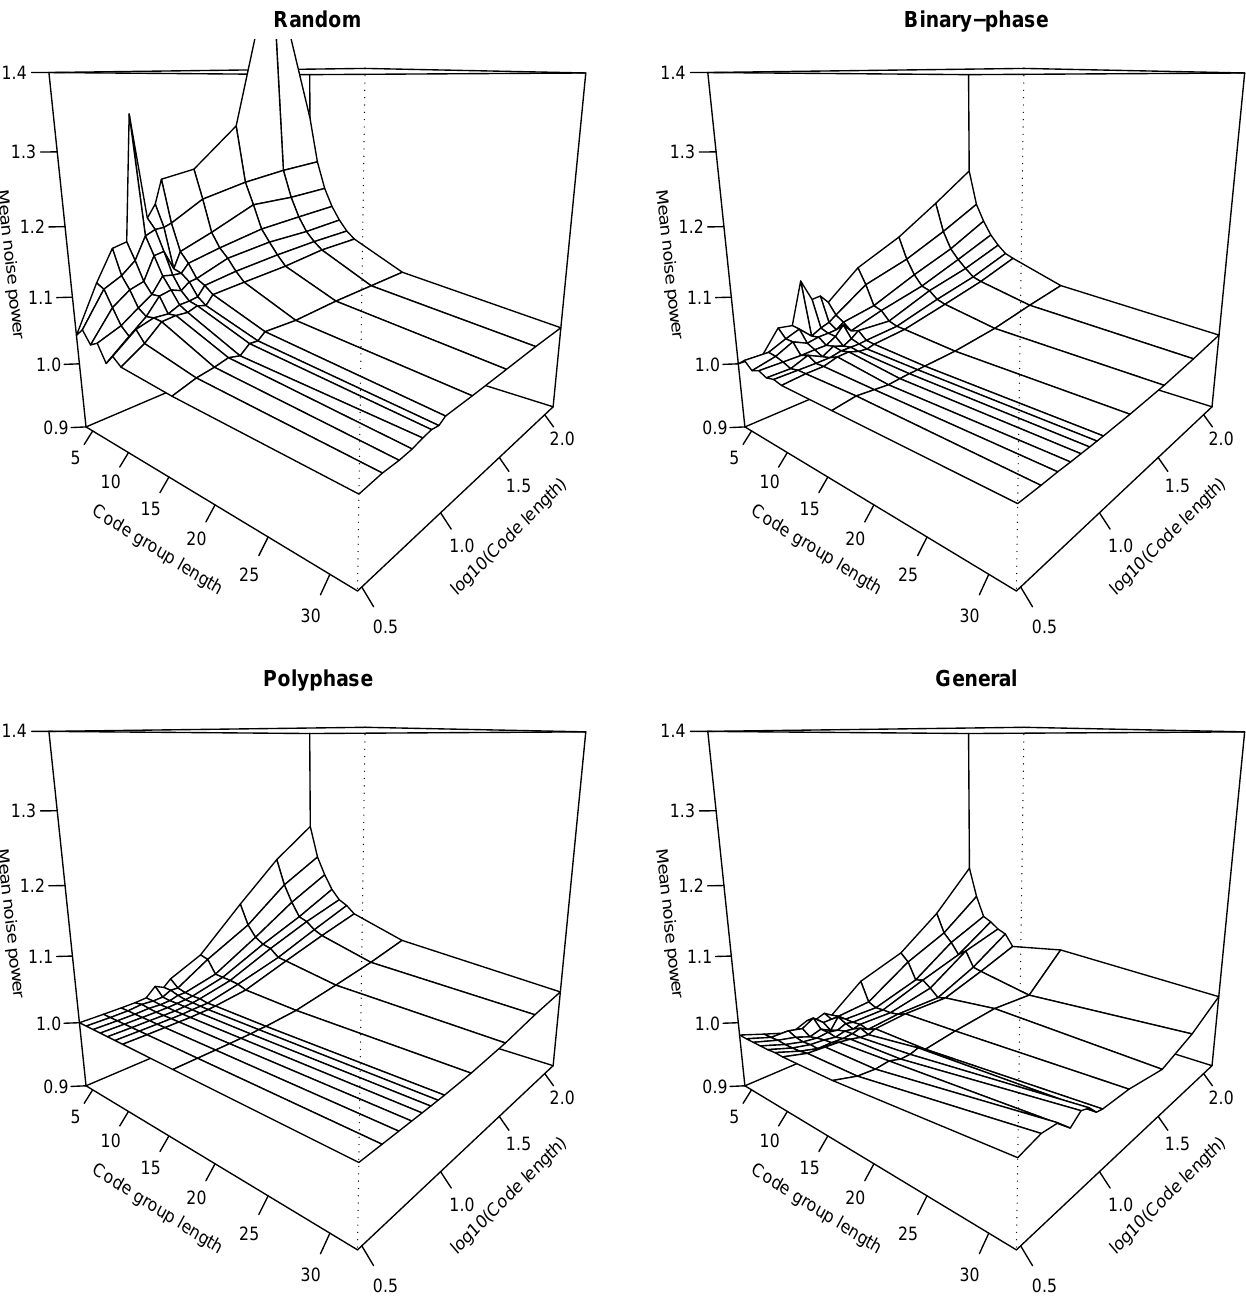
Fig. 1. The mean lag noise power for random binary phase codes, optimized binary phase codes, optimized polyphase codes and optimized amplitude a k ∈[ 0 , 2 ] and arbitrary phase modulated (general modulation) codes. The largest improvements are achieved for short code groups. Also, it is clear that the combination of amplitude and phase modulation provides the best lag